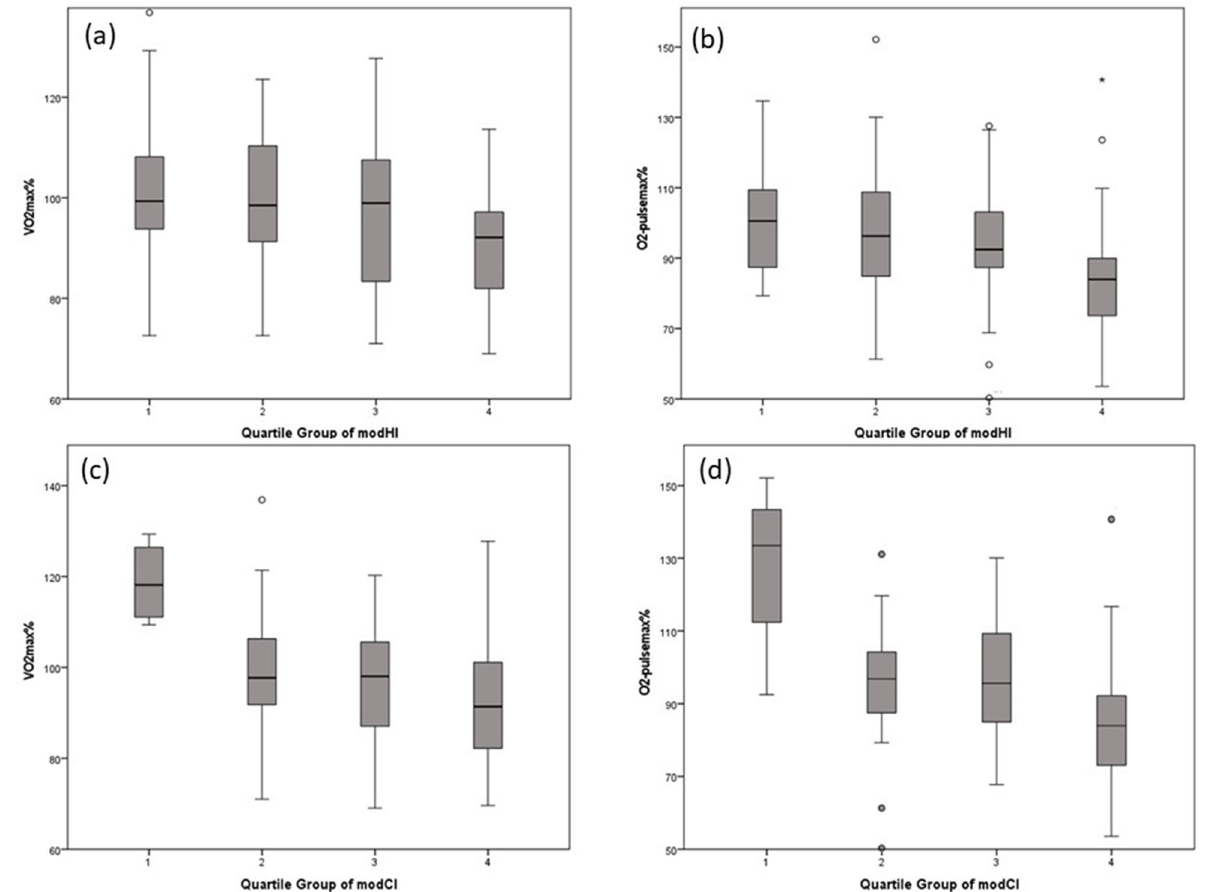
Figure 5. VO 2max % and O 2 -pulse max % according to quartiles of modHI and modCI. ( a , b ) depict boxplots of VO 2max % and O 2 -pulse max % according to quartiles of modHI; ( c , d ) depict boxplots of VO 2max % and O 2 -pulse max % according to quartiles of modCI.